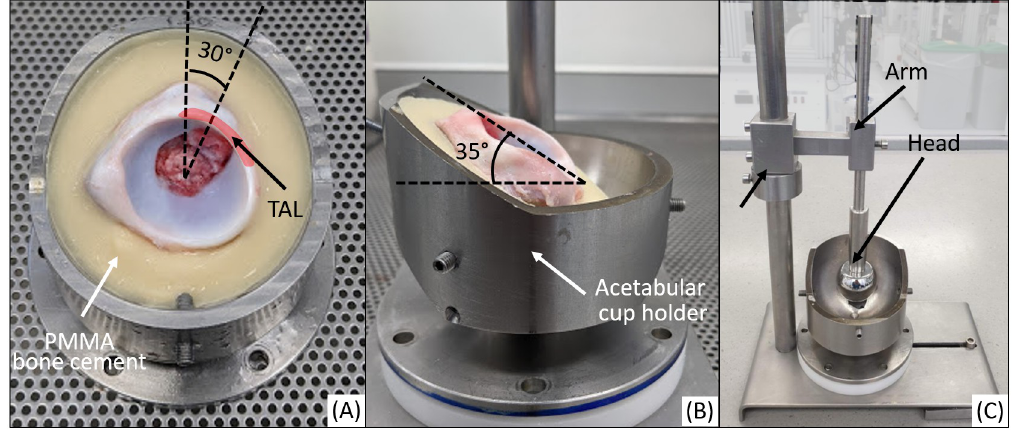
Fig 5. Experimental acetabular cup holder. Inverted compared to position in Fig 4 and including a cemented porcine acetabulum showing: (A) the acetabular version angle (whereby TAL indicates the transverse acetabular ligament), (B) the acetabular inclination angle (C) acetabular height set using a metal head attached the fixture via an